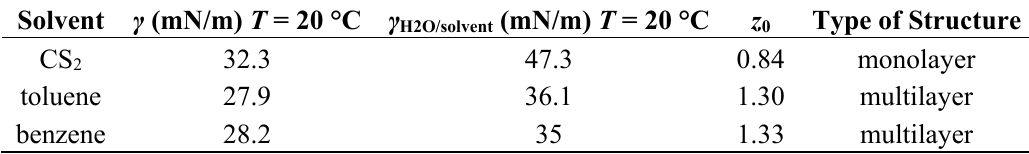
Figure 3. Schematic view of a spherical water droplet at the air/solution interface, with copyright permission from [47]. γ s and γ w , the surface tension of solution and water, respectively; γ w/s , the interfacial tension between water and the solution; z , the distance between the water droplet center and surface; R , the radius of the spherical water droplet. Table 1. The honeycomb film structures predicted from z 0 values, with copyright permission from